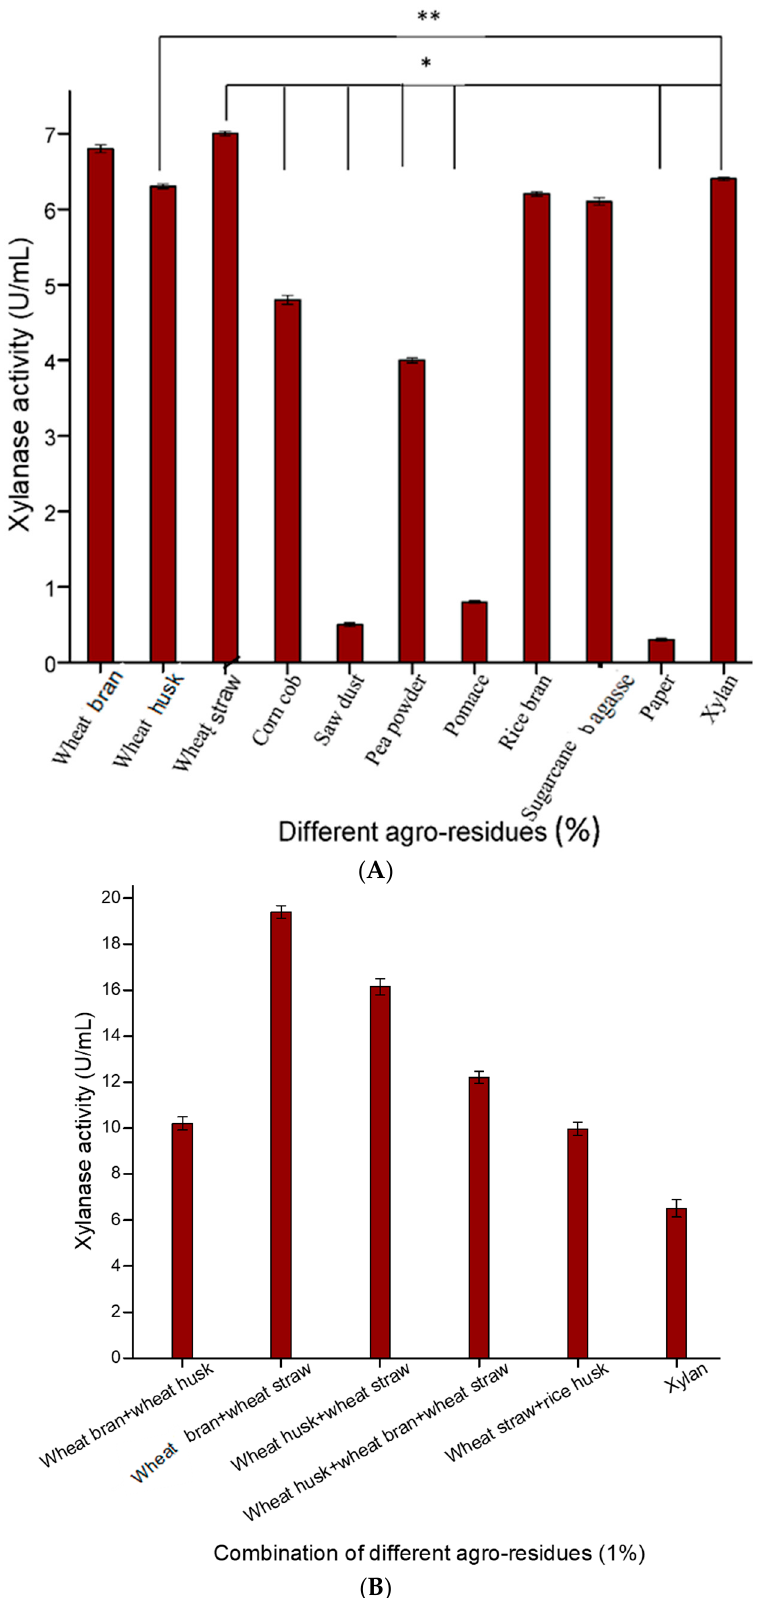
Figure 1. ( A ) Screening of different types of agro-residues for the production of xylanase by B. safensis XPS7. All the experiments were performed in triplicate. The results are expressed as mean ± SD and statistical analysis was performed using a one-way ANOVA with a Tukey post hoc test. Differences between means were considered to be significant if the calculated p -values were p < 0.05 **